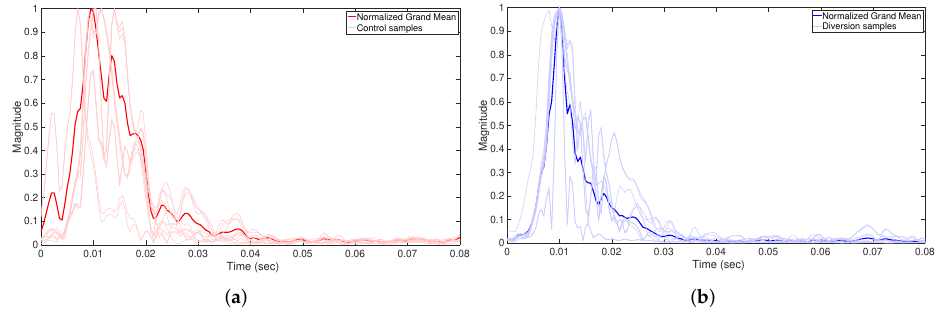
Figure 6. Correlation envelopes of diversion and control samples. Each sub-figure shows a plot of 40 samples selected randomly from the datasets, in addition to the mean of all samples in the datasets. ( a ) Diversion samples. ( b ) Control